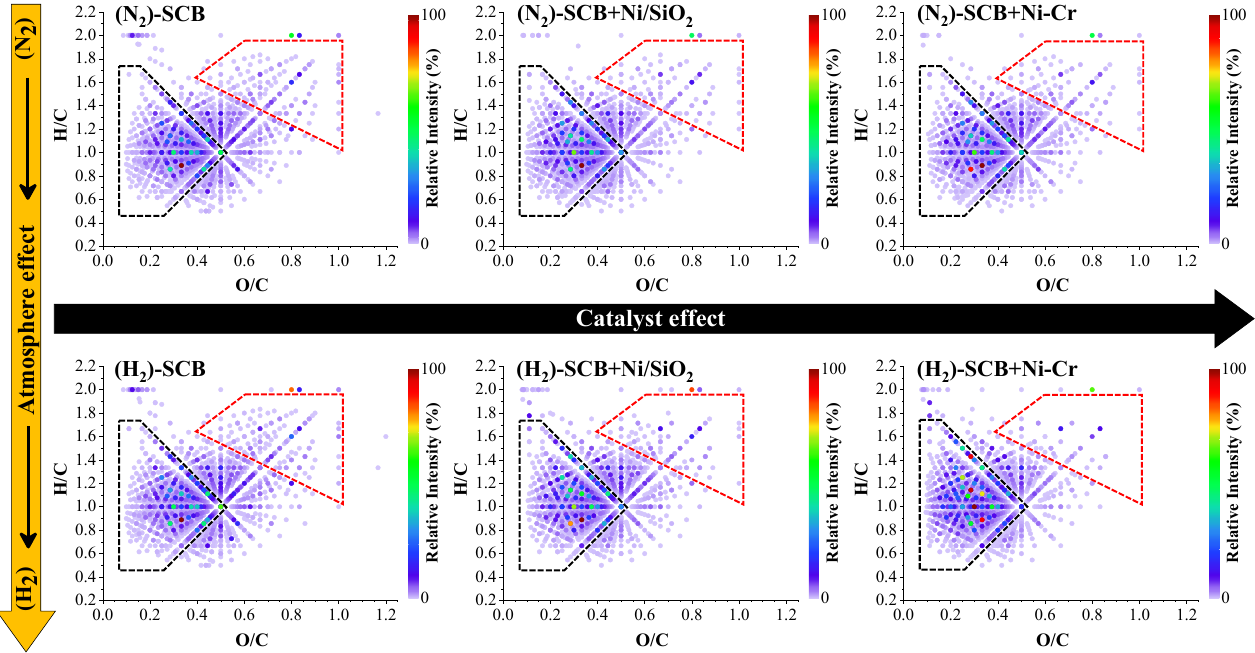
Figure 4. Van Krevelen diagrams for all classes of oxygenated compounds analyzed by HESI( − )-FT- Orbitrap MS.